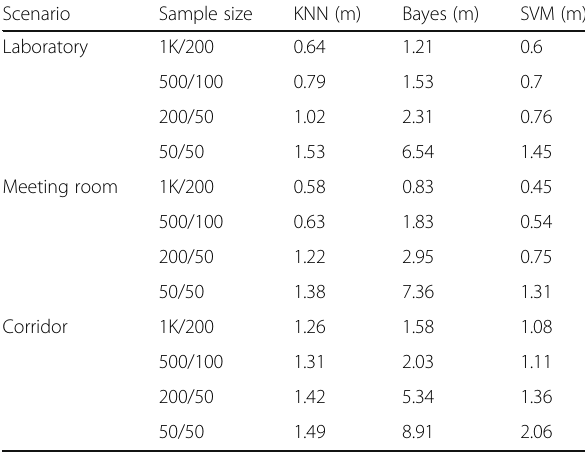
Table 3 MDE for different sizes of training and estimation